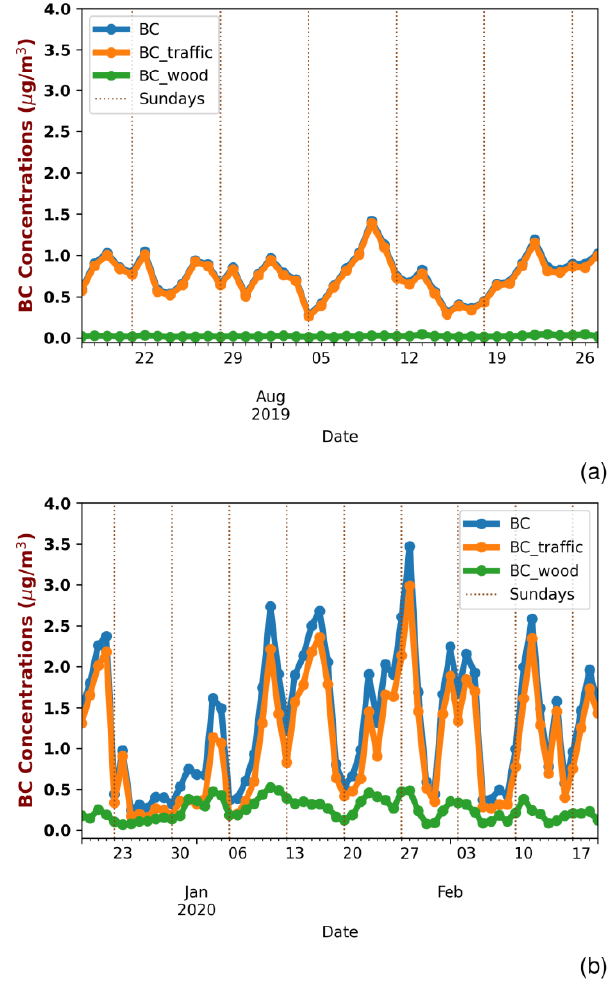
Figure 4. Daily mean variation of the BC mass concentrations (μg/m 3 ) along with the contribution of the fossil fuel and wood burning to the total BC mass concentrations, during ( a ) the summer and ( b ) winter PANACEA campaign in Thessaloniki station. Sundays are also marked with dashed lines.